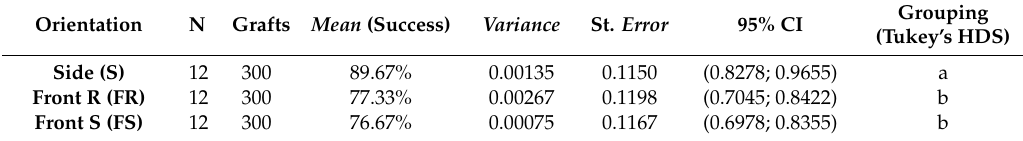
Table 2. Comparison between the average successes of the di ff erent orientations tested. Grouping of